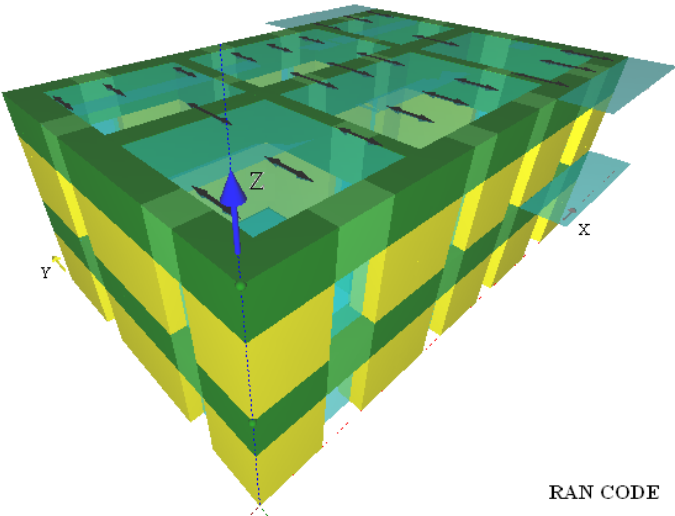
Figure 4. 3D macroelement model of case-study masonry